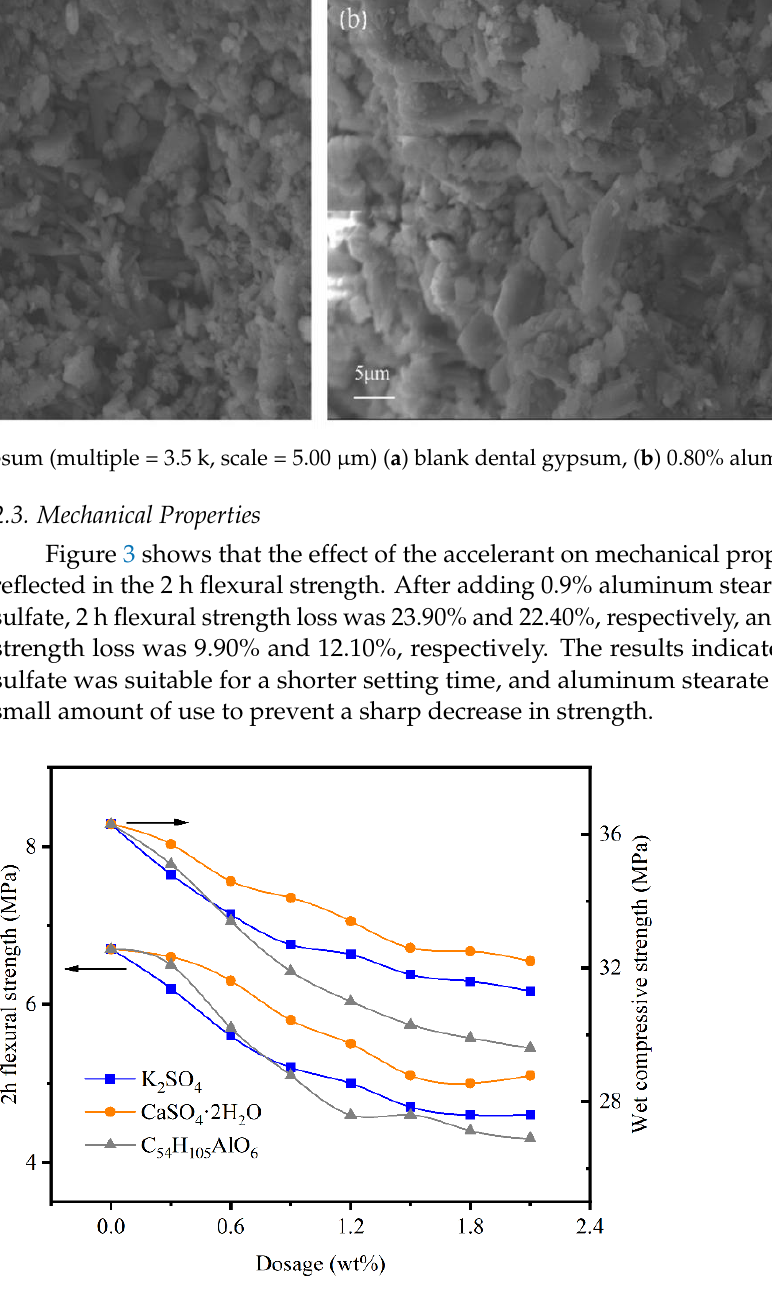
Figure 3. The effect of accelerant on the mechanical strength of dental gypsum.